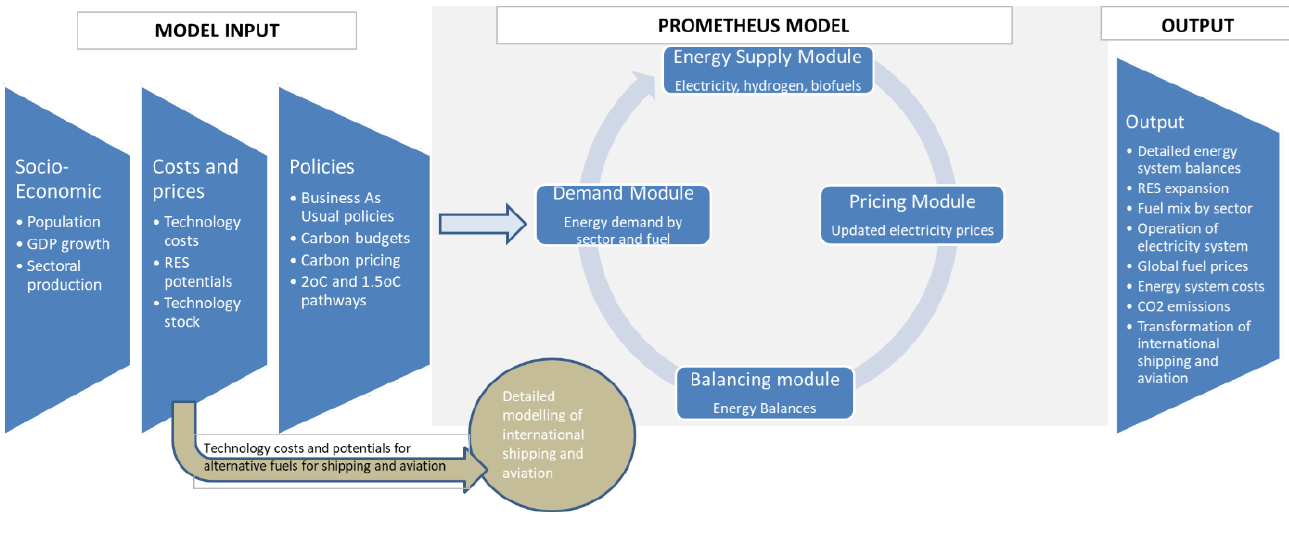
Figure 2. Schematic flow of the research study design.